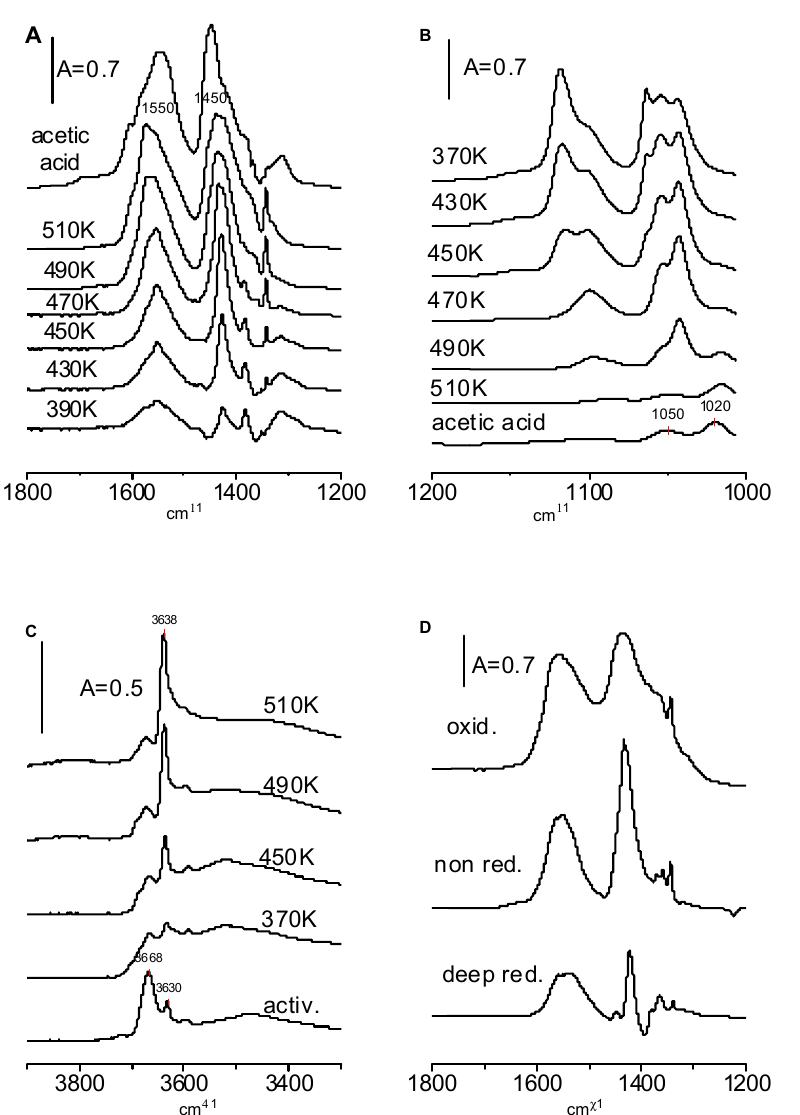
Figure 9. ( A,B,C ) – The spectra recorded upon the formation of ethoxy groups on CeO 2 and heating. D – The spectra of acetate ions formed on non-reduced, deeply reduced, and oxidized CeO 2